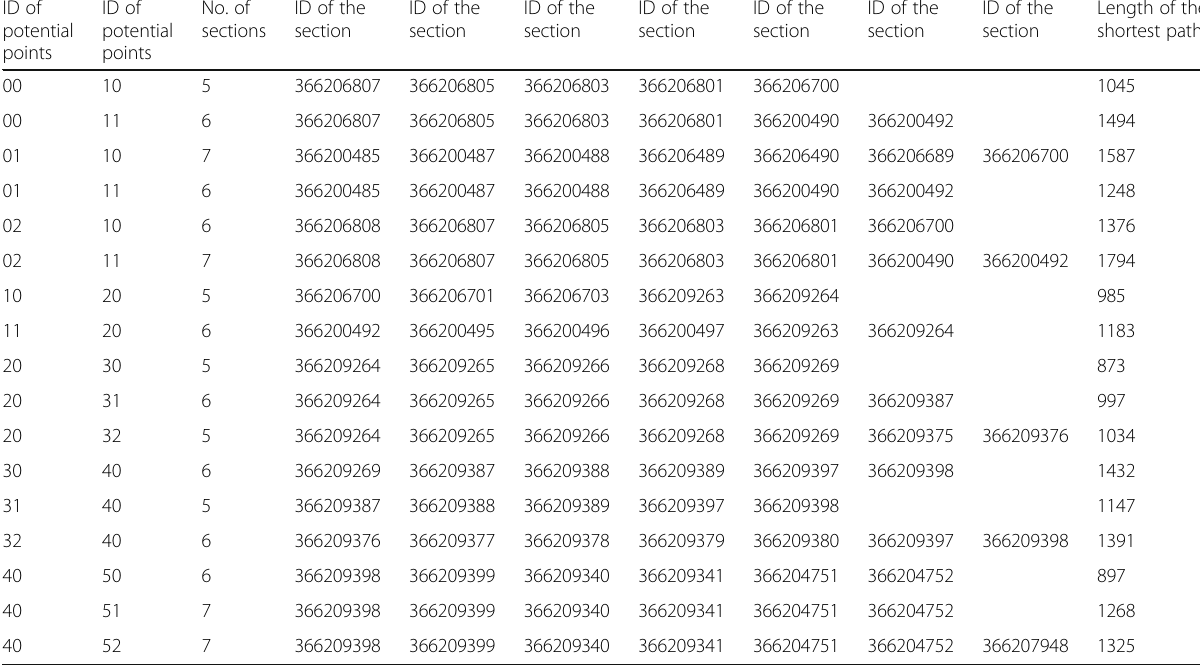
Table 1 Shortest path between some potential